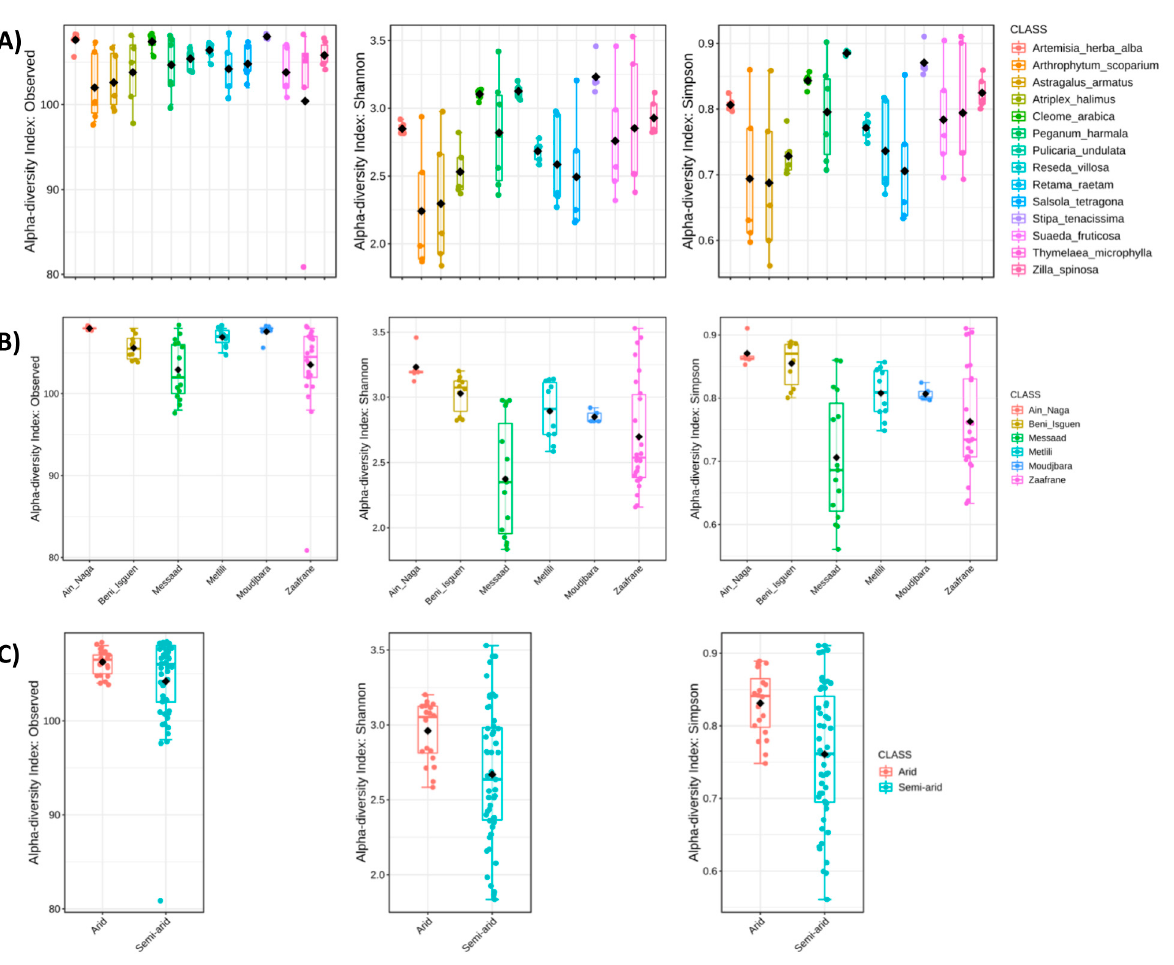
Figure 2. Alfa diversity analysis at species level. ( A ) Number of observed species ( p -value 0.0111), Shannon’s Index ( p -value 0.0011) and Simpson’s index ( p -value 0.0011) in the different plant species. ( B ) Number of observed species ( p -value 0.0001), Shannon’s Index ( p -value 0.0001) and Simpson’s index ( p -value 0.0001) in the different sampling sites. ( C ) Number of observed species ( p -value 0.1949), Shannon’s Index ( p -value 0.0061) and Simpson’s index ( p -value 0.0046) in the two climatic zones. p -value cut-off for significance is 0.05. In the figure, black dot indicated mean value while the colored line represented the median value. Alpha diversity analysis was performed using the phyloseq package of MicrobiomeAna-lyst.